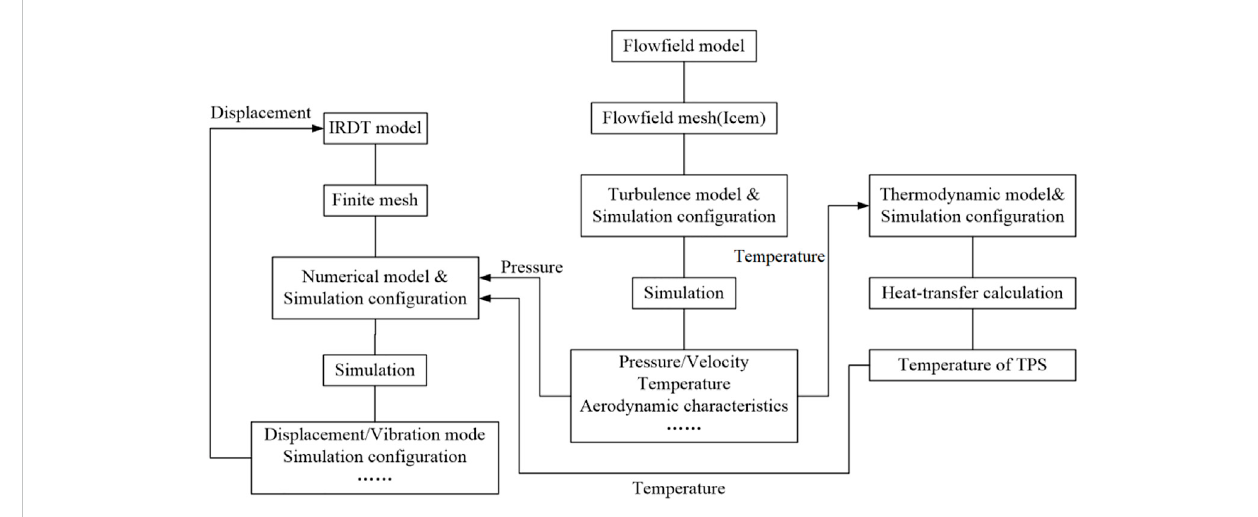
FIGURE 2 Flow chart of coupling analysis and data transfer.